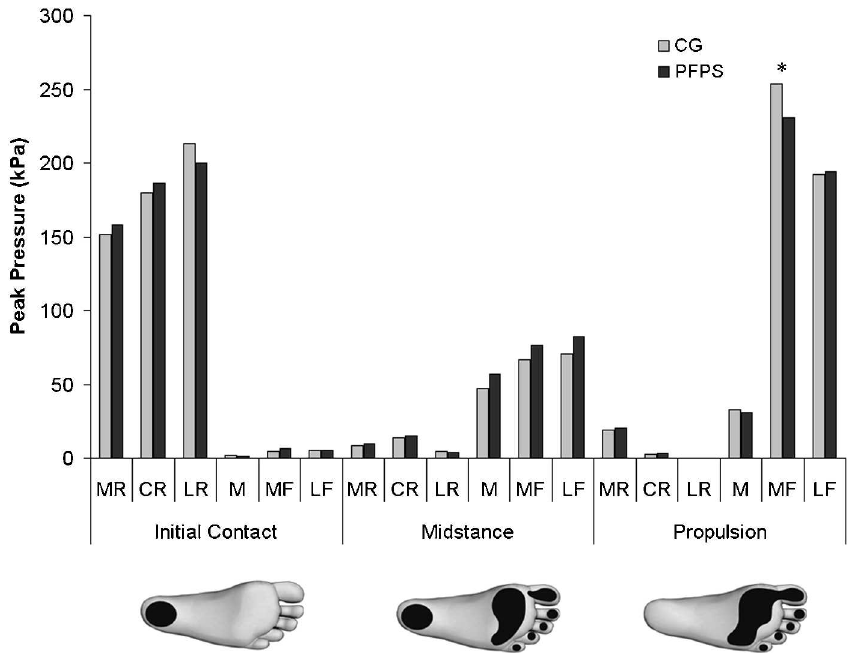
Figure 4 - Mean values of the peak pressure (kPa) in six plantar areas (MR=medial rearfoot, CR=central rearfoot, LR=lateral rearfoot, M=midfoot, MF=medial forefoot and LF=lateral forefoot) during initial contact, midstance and propulsion. (CG=control group, PFPS=patellofemoral pain syndrome, * p ,